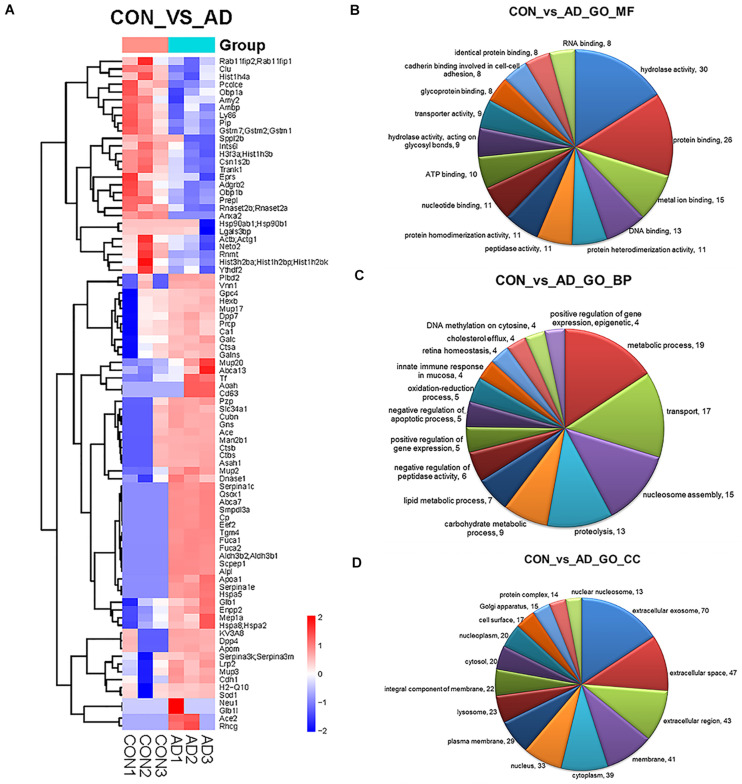
Comparison of the proteomics analysis by hierarchical cluster and gene ontology. (A) Heatmap illustrating the classification of control and 5XFAD mice (x axis) based on the deferentially expressed proteins (y axis) and unbiased clustering analysis in urinary exosomes. (B–D) Pie diagrams of Gene ontology (GO) analysis of the differentially expressed proteins was performed to study the specific MFs, BP, and CCs (the top 15 counts are shown) Comparison between control and 5XFAD mice samples in term of number of genes identified for different GO terms. Amounts of the top 15 terms with P-value < 0.05.